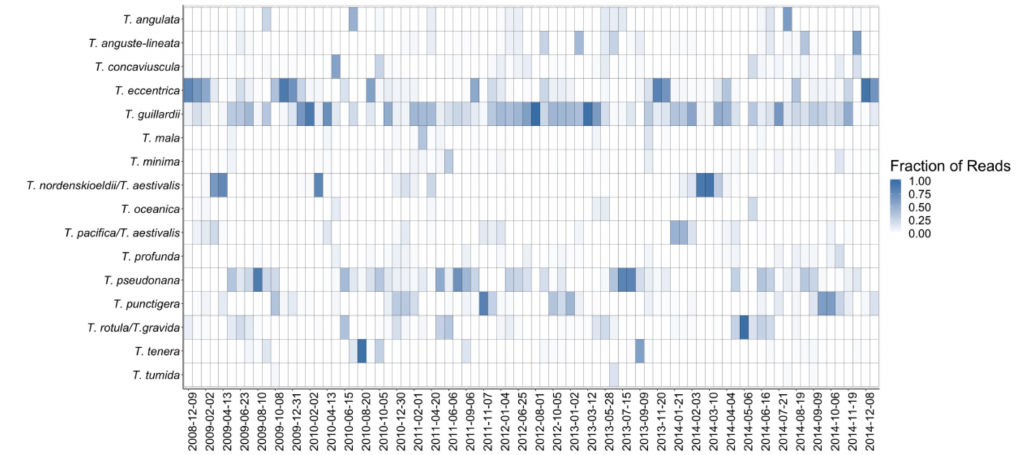
Figure 3. Heatmap showing relative abundance of sequence reads representing 16 Thalassiosira species identified using the metabarcoding approach. Samples were collected monthly between 2008 and 2013 and semi-monthly for 2014. Sample dates are represented in